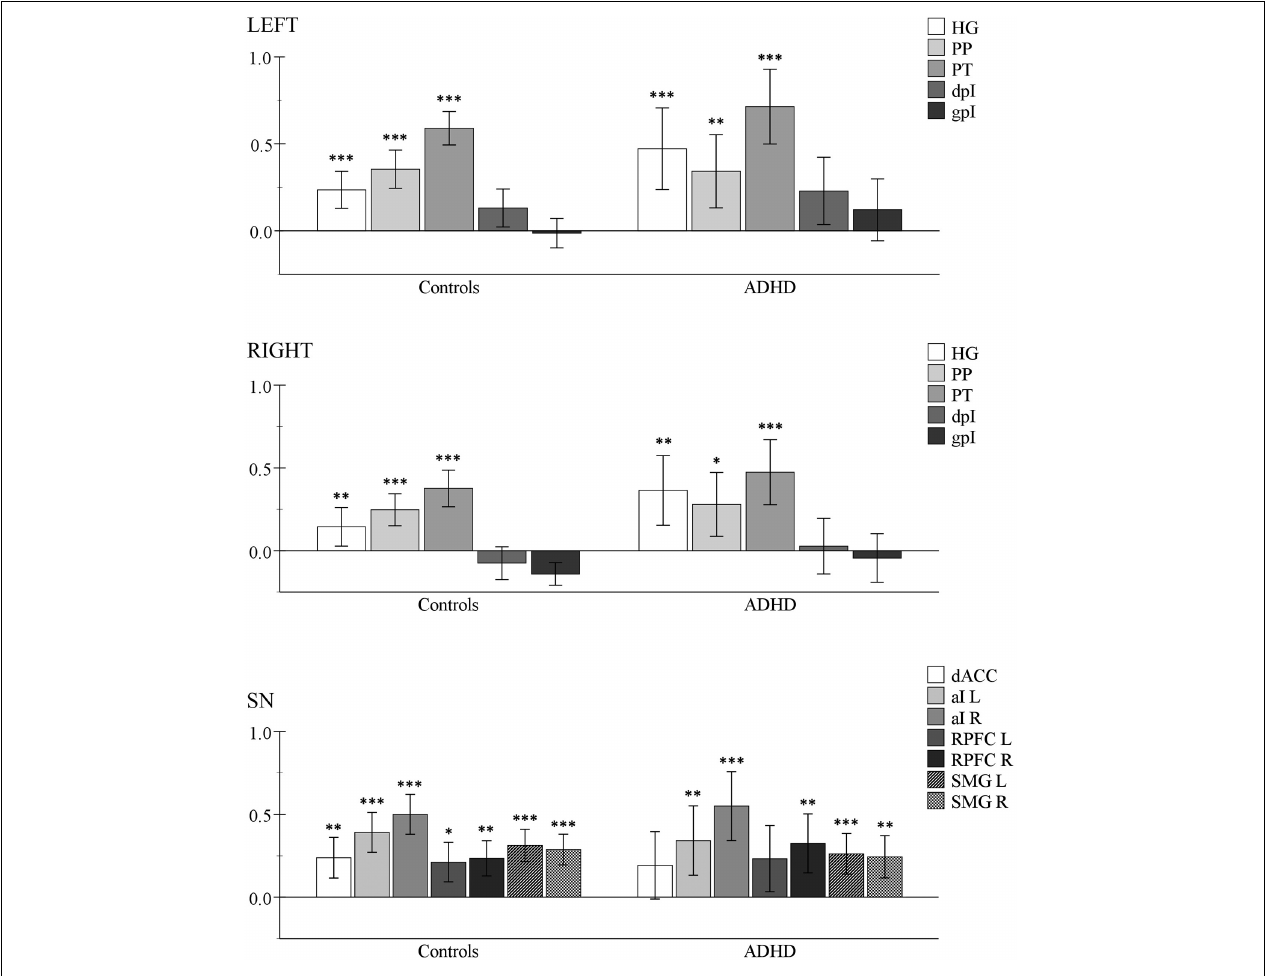
FIGURE 2 | Within-group analysis results for the auditory target detection contrast (ATD > rest). One-sample t- tests were used to determine if the mean BOLD activity within each ROI (per group) was greater than zero. Y -axis corresponds to mean beta image values. Asterisks indicate Bonferroni-corrected levels of significance: ∗ p < 0.05, ∗∗ p < 0.01, ∗∗∗ p < 0.001; error bars = 95% CI. Top panel: left auditory ROIs. Middle panel: right auditory ROIs. Bottom panel: salient network (SN) hub-regions. HG, Heschl’s gyrus; PP, planum polare, PT, planum temporale, dpI, dysgranular posterior insula; gpI, granular posterior insula;